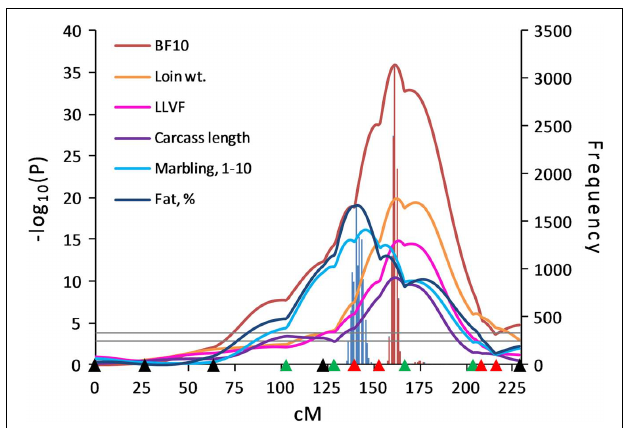
FIGURE 4 | Quantitative trait loci results determined by different models for pH related traits on SSC3. Line-cross model detected a QTL ( q < 0.01) for 45min pH (red line) and half-sib model detected a QTL ( q < 0.01) for 45min carcass temperature (blue line). Combined model identified a QTL ( q < 0.01) affecting pH decline from 45min to 24h (green line). Marker positions are shown as triangles on the X -axis (black, markers used for both QTL scans and genotyped only in 510 animals; green, markers used for both QTL scans and genotyped in all animals; red, markers used for second scan only and genotyped in all animals). Horizontal lines indicate significance thresholds (lower line, 5% FDR; upper line, 1% FDR). QTL affecting the a ∗ and b ∗ objective color measures were newly detected on SSC12 ( q < 0.04). In order to determine how the